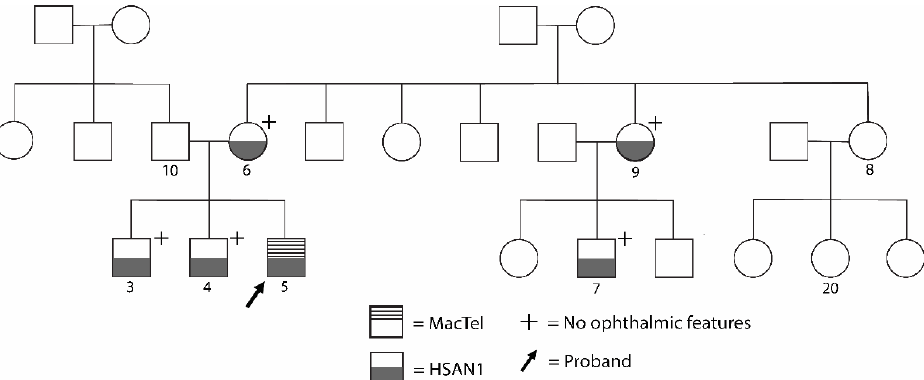
Figure 3. Pattern of inheritance of HSAN1 and MacTel2 in the proband’s family. Pedigree describing the phenotypes of HSAN1 and MacTel2 in the proband (individual 5) and his extended family. The proband’s brothers (individuals 3 and 4), mother (individual 6), maternal aunt (individual 9), and cousin on maternal side (individual 7) are affected by HSAN1 per physical exam but not MacTel2 (confirmed by exam and ophthalmic imaging for individuals 3 and 4, by patient report for patients 6, 7, and 9). The proband is the only participant affected by MacTel2.